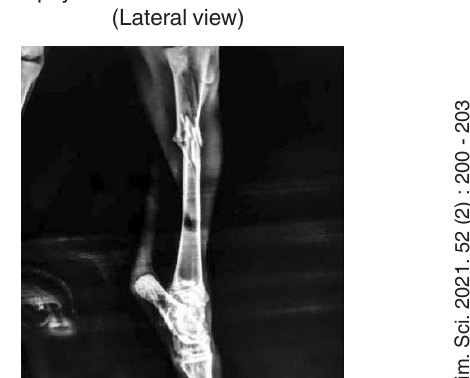
Figure 1: Preoperative radiograph showing a